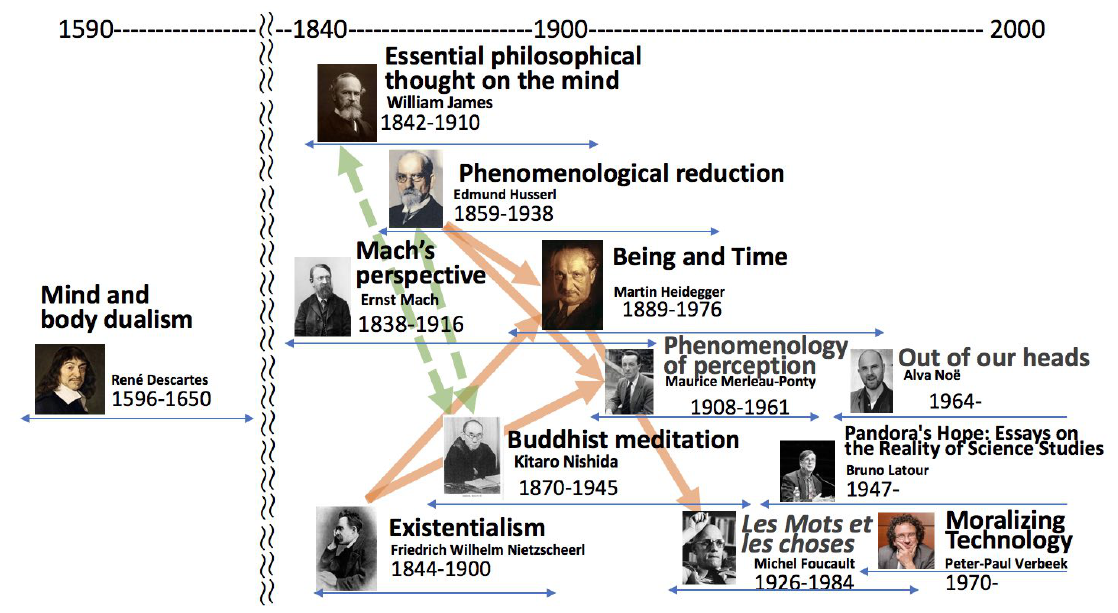
Figure 2. Ideological background of relations between human beings and